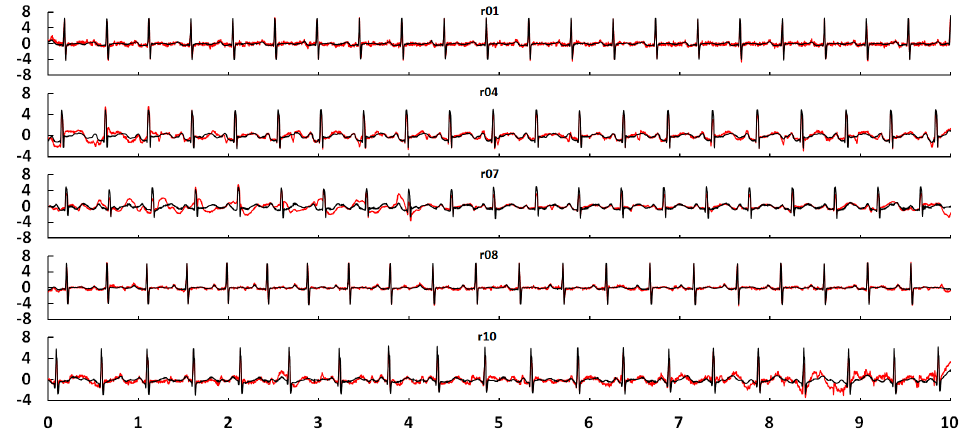
Figure 4. Direct scalp FECGs after filtering and eliminating baseline wandering in ADFECGDB.